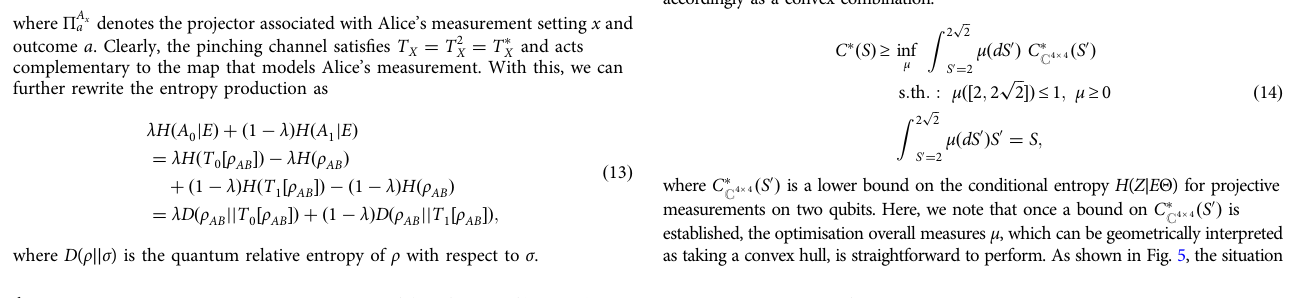
Fig. 5 Measurement setting for two-qubit states. Alice has two projective measurement that are described by projectors ð Π A 0 relative angle φ . Bob has in total four measurements: for key generation, ideally he should perform measurements B 0 and B 1 which are aligned with Alice ’ s measurements A 0 and A 1 to minimise the quantum bit error rates. The security analysis only depends on Bob ’ s measurements B 2 and B 3 , which are w.l.o.g. speci fi ed by a relative angle ω